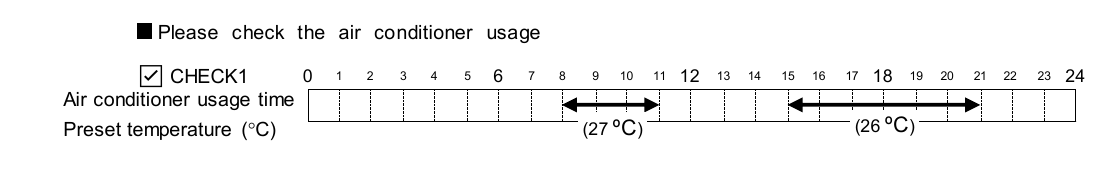
Figure 7. Checklist of air-conditioner-usage time, which is recorded by occupants.